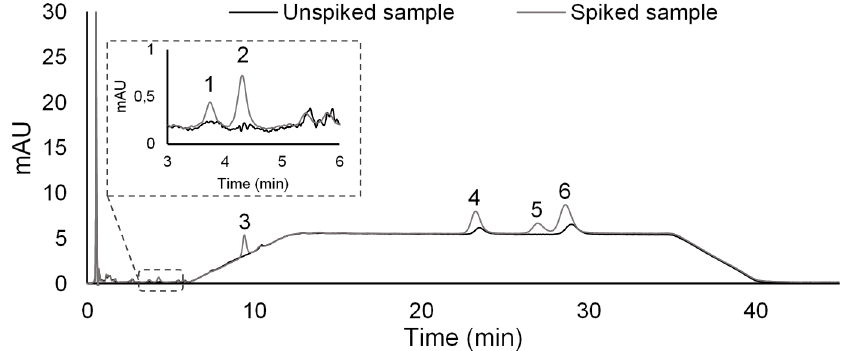
Figure 3. Chromatogram obtained from an assay performed on spiked (25.0 μ g L − 1 ) and unspiked wastewater samples obtained by BA μ E(R, 12.5%/CN1, 87.5%)- μ LD/HPLC-DAD under optimized